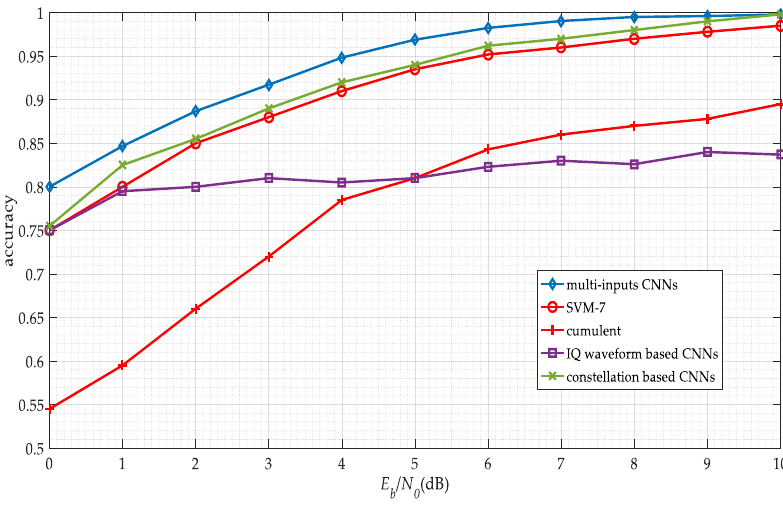
Figure 14. Di ff erent methods performance versus Figure 14. Different methods performance versus SNR. Figure 14. Different methods performance versus SNR.